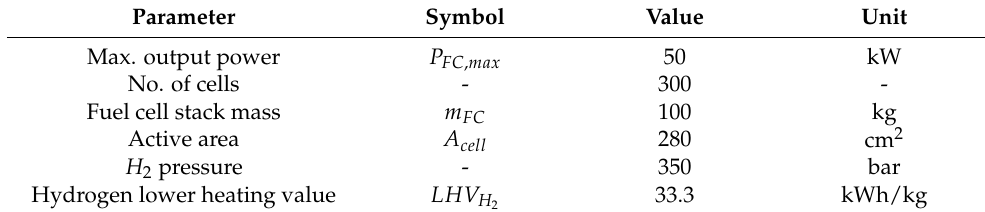
Table 3. Fuel cell system specification.